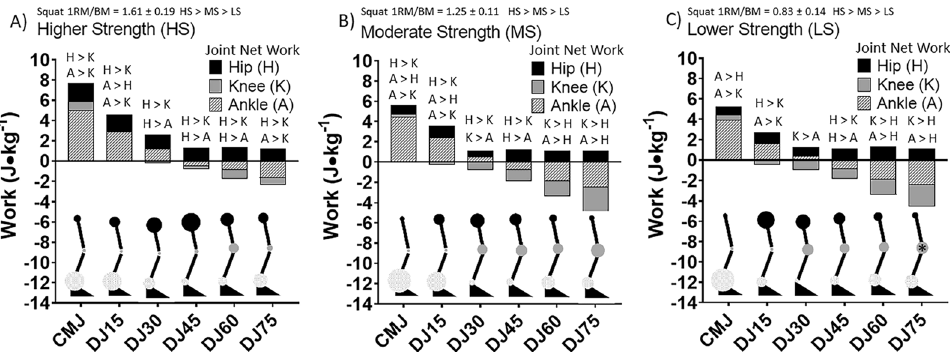
Fig. 2 Comparison of net work (J) for the hip, knee and ankle between A higher strength (HS), B moderate strength (MS) and C lower strength (LS) groups for the countermovement jump (CMJ) and drop jumps (DJ) from 15, 30, 45, 60 and 75 cm. Significances indicated at p A > K, A > H, H > A, K > A, K > H significances indicated at p 0.05. *Indicates the knee net work (J) was significantly great in LS in comparison with ≤ HS at p 0.05. The size of the circles at each joint is a scaled quantitative representation of the relative amount of net work (J) performed by that ≤ respective joint. Reproduced from McBride and Nimphius [39], with